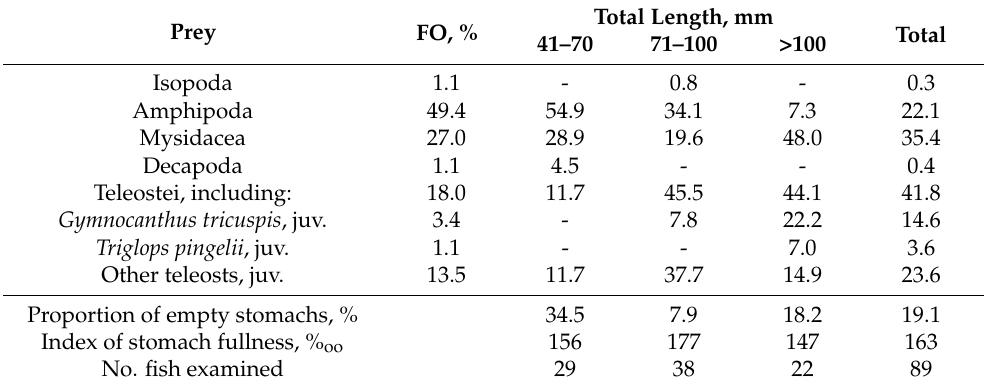
Table 4. Diet composition (% by weight) of ribbed sculpin Triglops pingelii in the Kara Sea, September 2019 (FO = frequency of